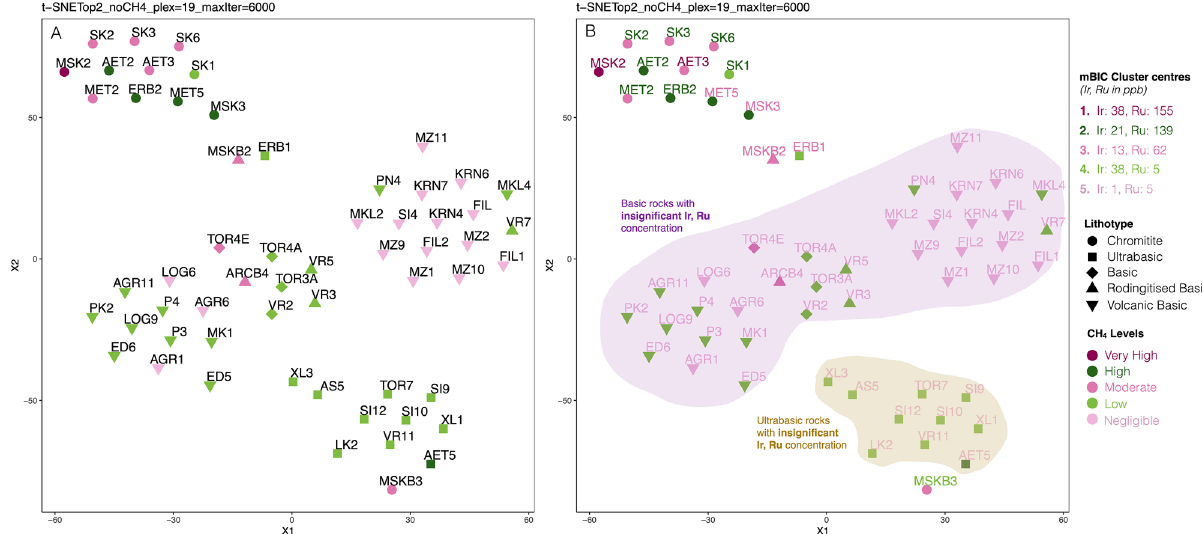
Figure 1. Optimal t-SNE plots of the potential catalyst proxies at 6000 iterations. ( A ) Top 2 Features (Ir, Ru) provide the ideal classification of the expected methane levels in the rock samples. ( B ) mBIC clustering over- imposed on the Top 2 features t-SNE plot. Abbreviations, plex: perplexity value, maxIter: maximum iterations (repetitions) of the algorithm.